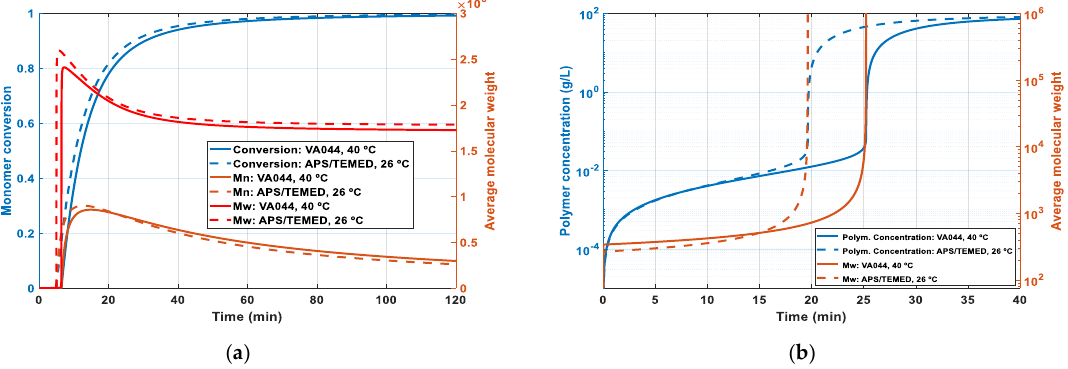
Figure 14. Simulation of the effect of the initiation system (VA-044 at 𝑇 = 40 ° C or APS/TEMED at 𝑇 = 26 ° C) on the dynamics of polymerization and gelation. ( a ) AAm polymerization with 𝑌 𝑀 = 9% and 𝑌 𝐼 = 0.2%. ( b ) AAm/MBAm copolymerization with 𝑌 𝑀 = 9%, 𝑌 𝐶𝐿 = 1.0%, and 𝑌 𝐼 = 0.2%.